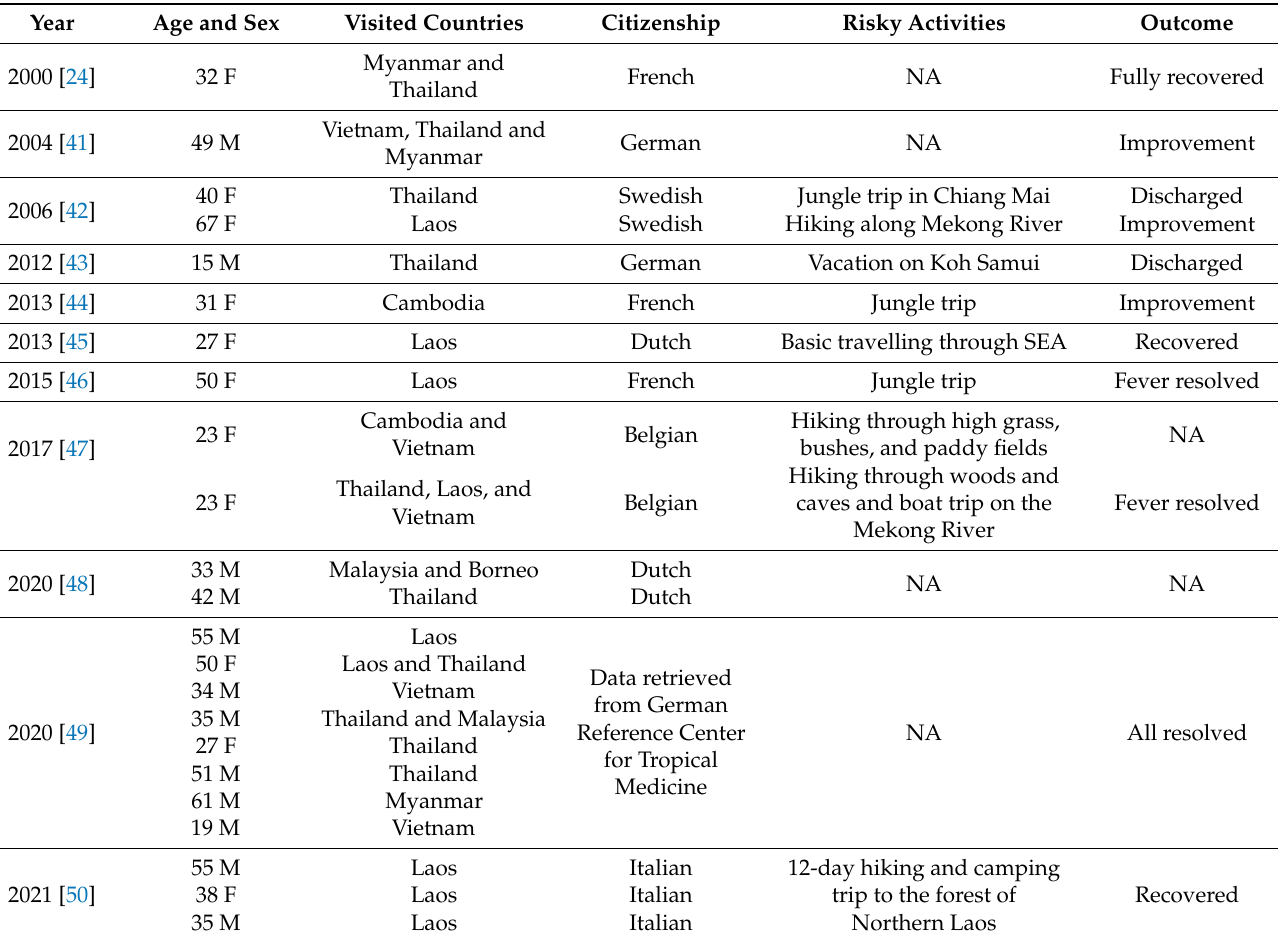
Table 1. Demographic and epidemiologic features of international travellers diagnosed with scrub typhus in Southeast Asia,